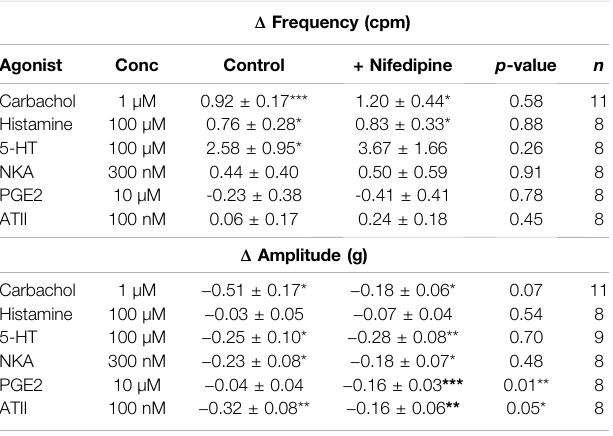
TABLE 2 | U&LP change in frequency and amplitude responses to receptor agonists in the absence (control) and presence of nifedipine (1 µM). There were no signi fi cant differences between the average frequency changes between the absence and presence of nifedipine for any of the agonists. Data presented as mean ±